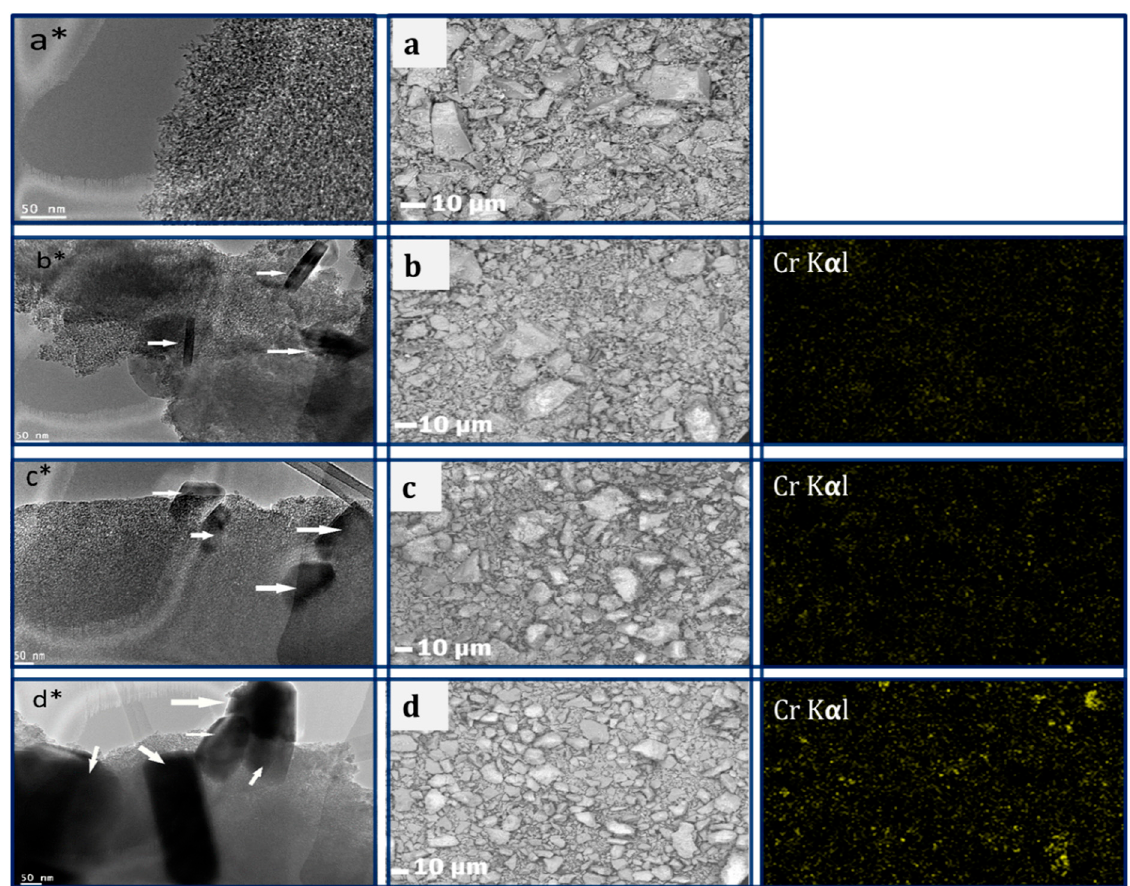
Figure 3. TEM, SEM images, and EDX elemental mapping (Cr (golden); Si (blue)) of Cr(x)/MOS catalysts prepared at different chromium loadings ( a* , a ) MOS; ( b* , b ) Cr(2)/MOS; ( c* , c ) Cr(8)/MOS; and ( d* , d ) Cr(11)/MOS (white arrows refer to Cr species).